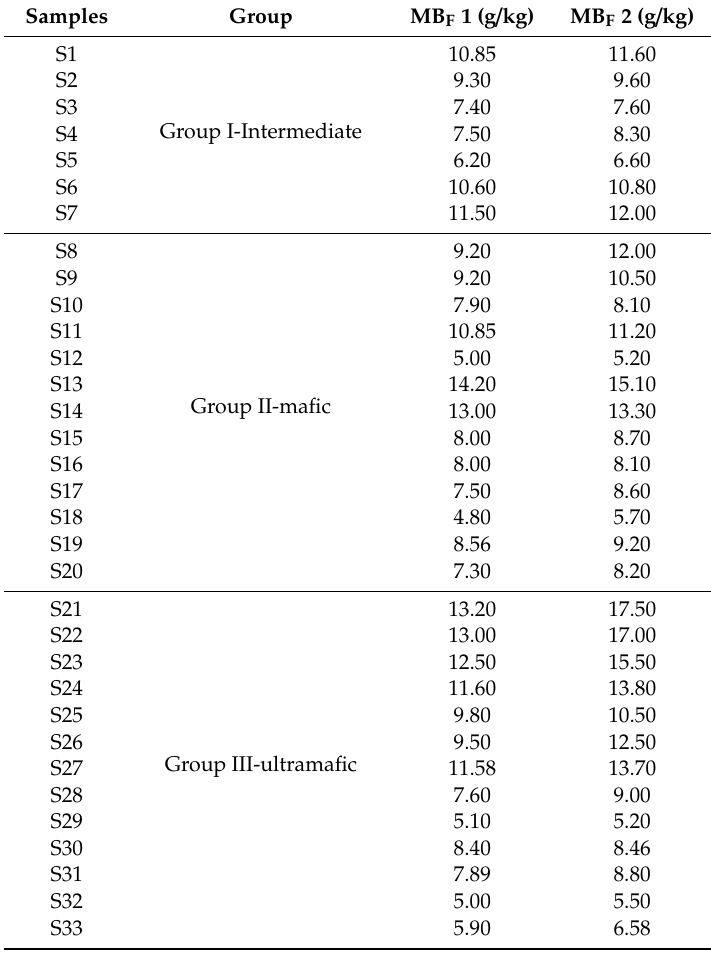
Table 4. The results of the methylene blue test (MB F ) and the modified methylene blue test (MB F 2) of the examined